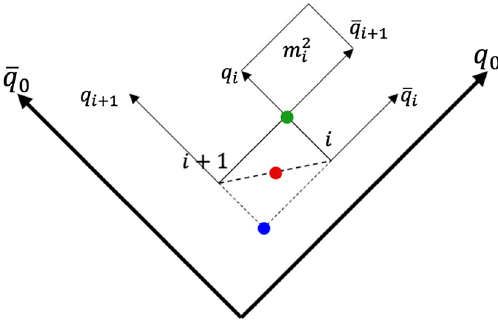
Fig. 9 Hadron formation in a q ¯ q system. The blue, red and green dots represent the “early”, “middle” and “late” definitions of hadron produc- tion points, respectively